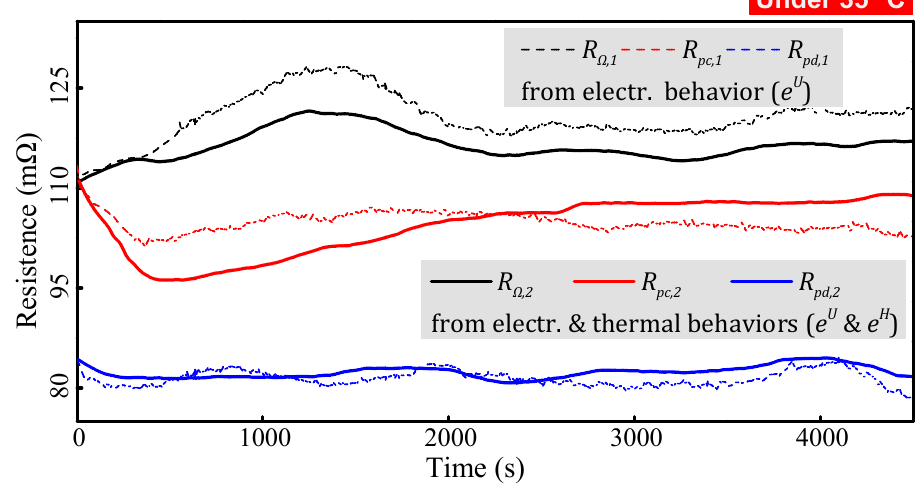
Figure 7. Changing trajectories of the ECM resistors.